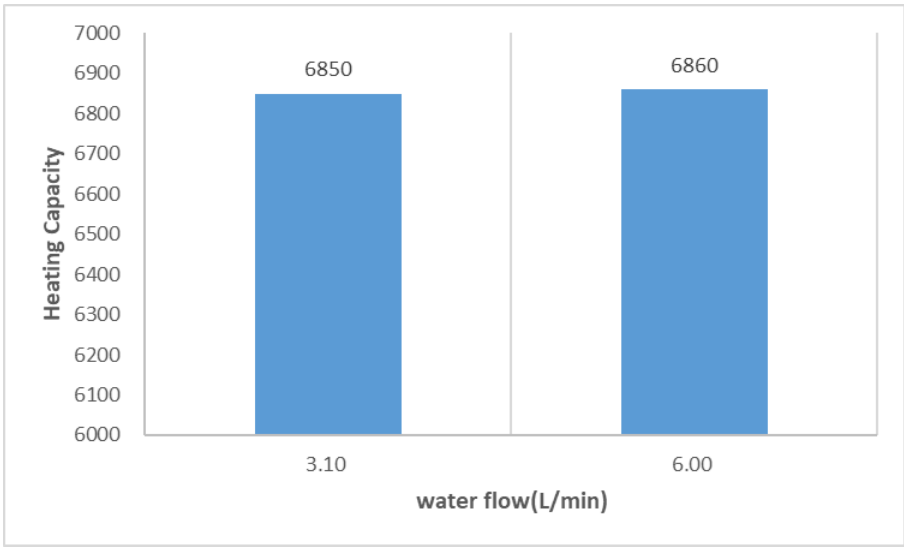
Figure 12. The heating capacity variation (in W) with different water flows.